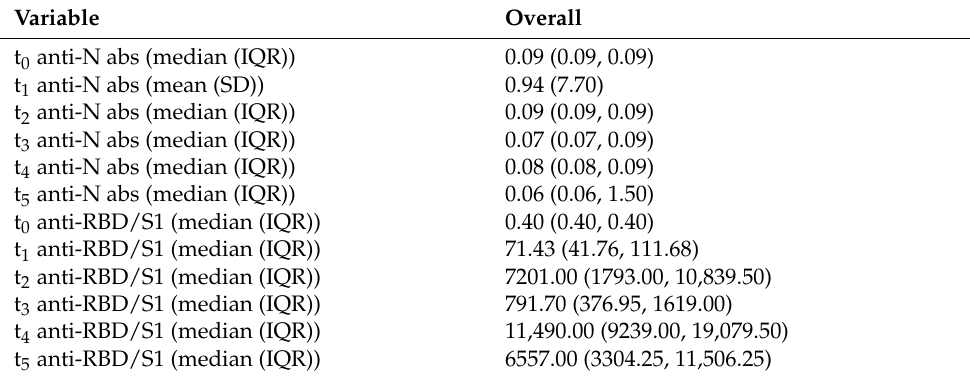
Table 2. SARS-CoV-2